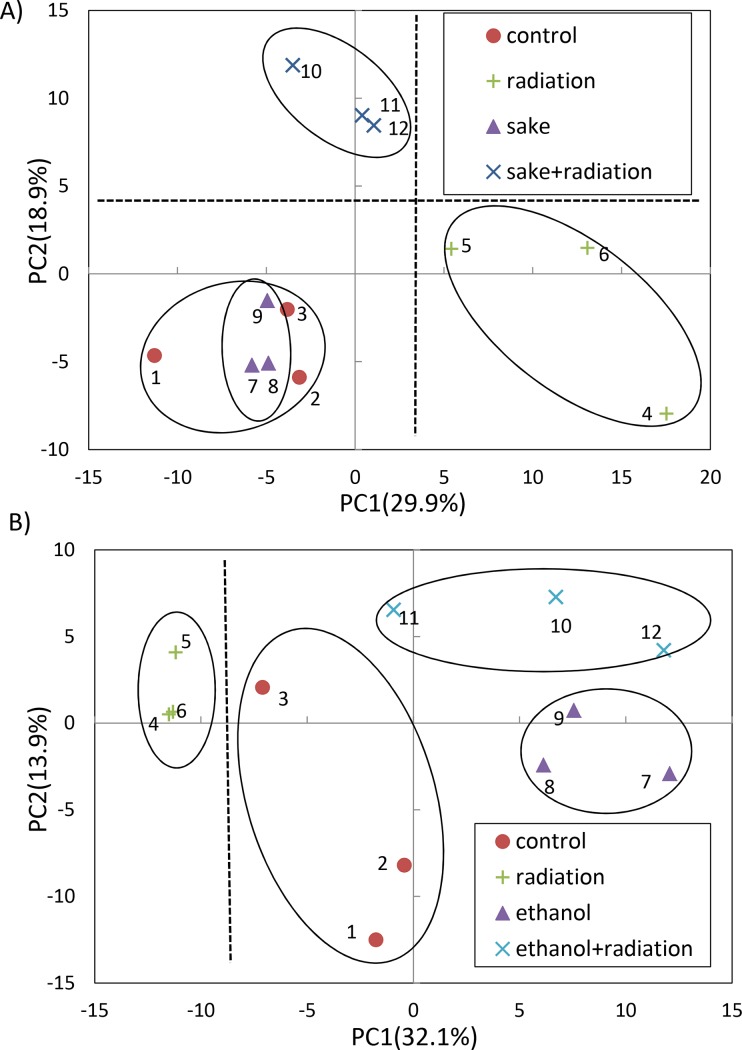
PCA of metabolic data for the combined effects of sake (or ethanol) and radiation on livers.(A) PCA in sake administration experiment, (B) PCA in 15% ethanol administration experiment. Percentage values indicated on the axes represent the contribution rate of the first (PC1) and second (PC2) principal components.